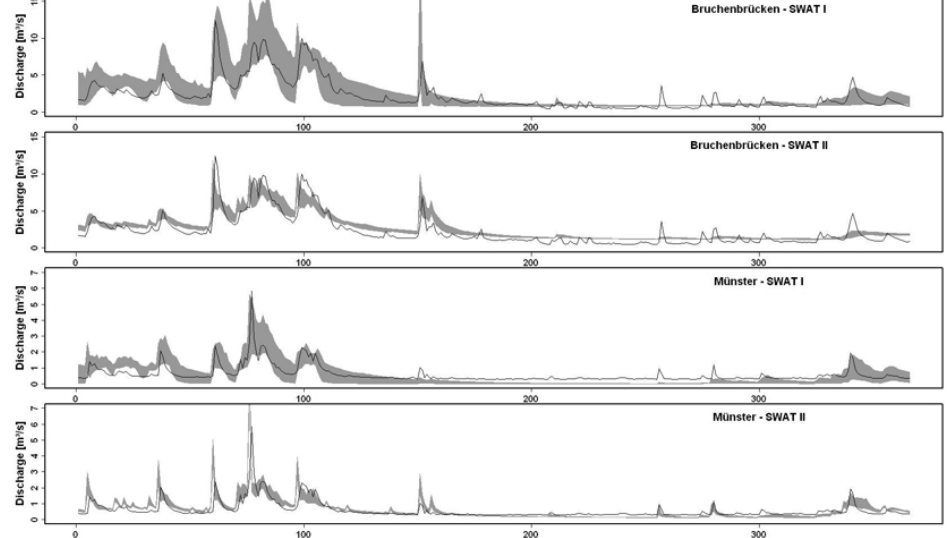
Fig. 5. Span of simulated (shaded grey) and observed (black line) discharge for the gauging stations Bruchenbr¨ucken and M¨unster for the year 2008 and the parameter ensembles of SWAT I and SWAT